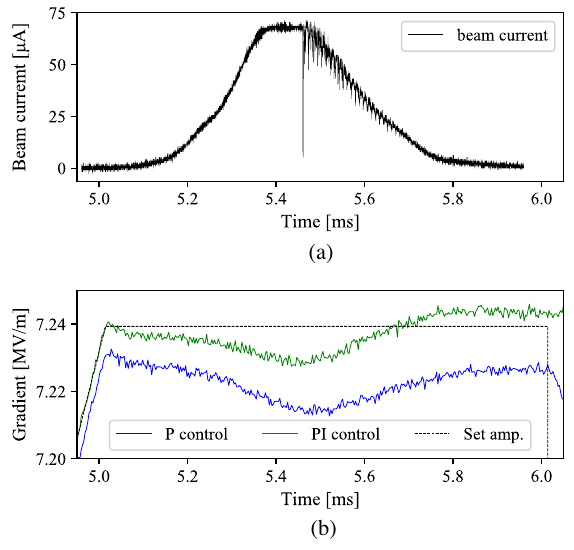
FIG. 11. (a) The 0.7 ms and 66 μ A peak current beam measured by the oscilloscope. (b) Measured rf field for the amplitude on ML2 in the case of P control (blue) and PI control (green).